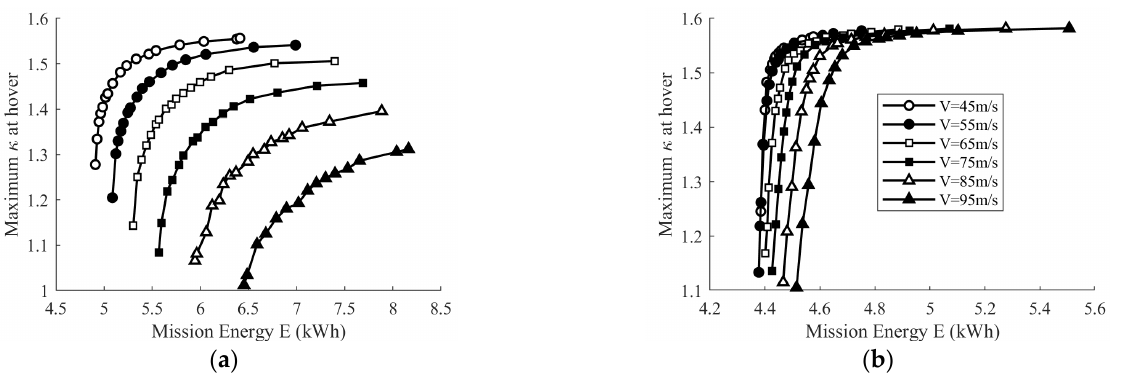
Figure 29. Pareto-optimal front of VPP and FPP with different cruising speeds. ( a ) Pareto fronts for FPP; ( b ) Pareto fronts for VPP.